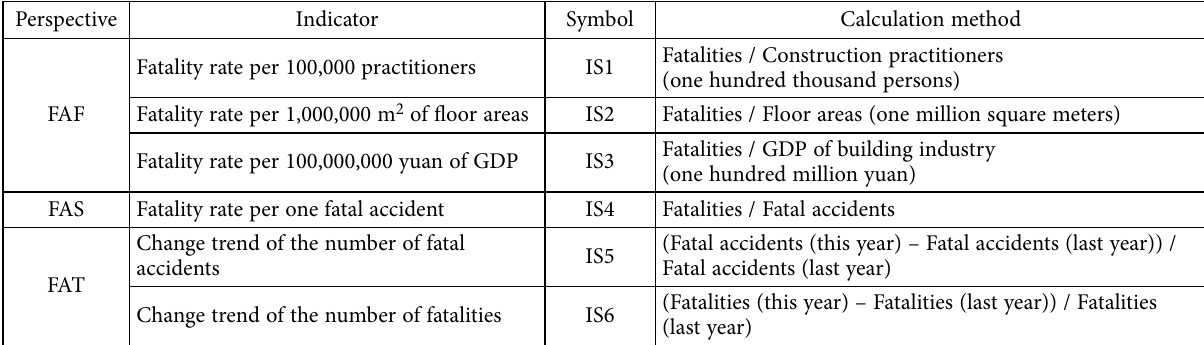
Table 1. Indicators measuring accident